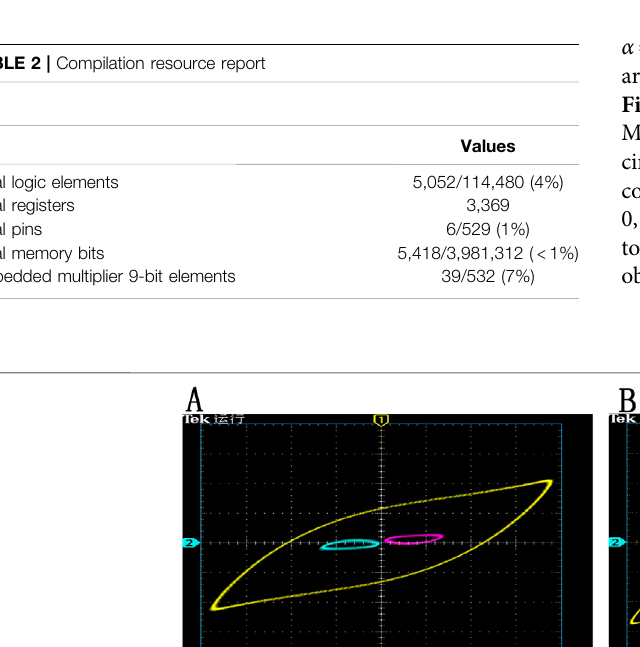
Frontiers in Physics |